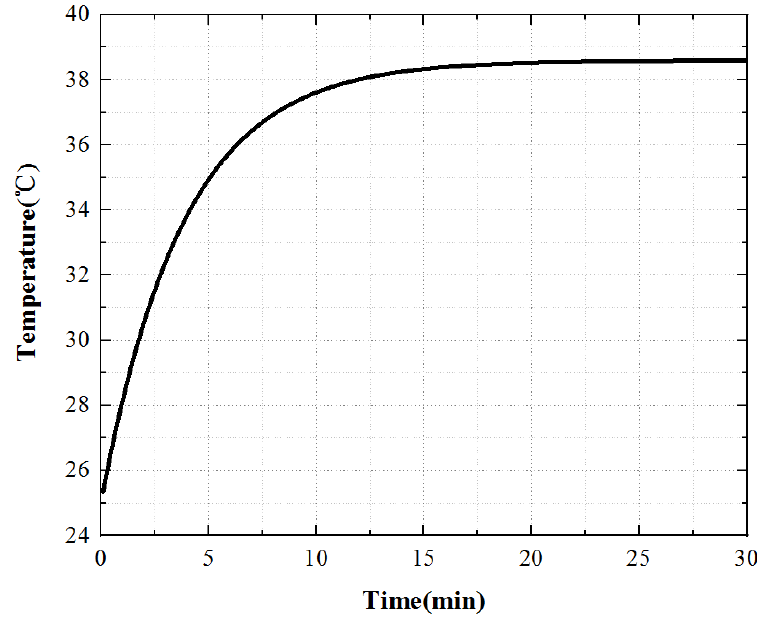
Figure 16. Temperature rise characteristic curve of the piezoelectric stator.